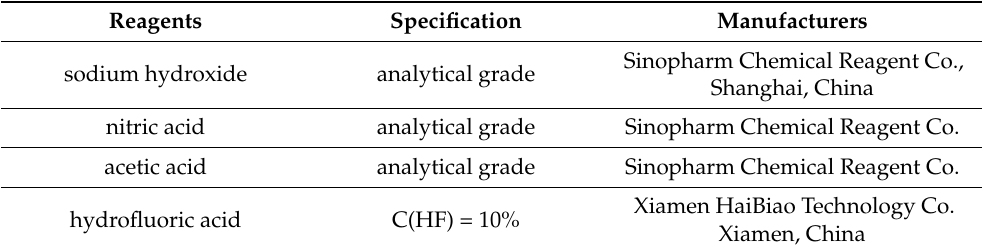
Table 1. Experiment reagents.